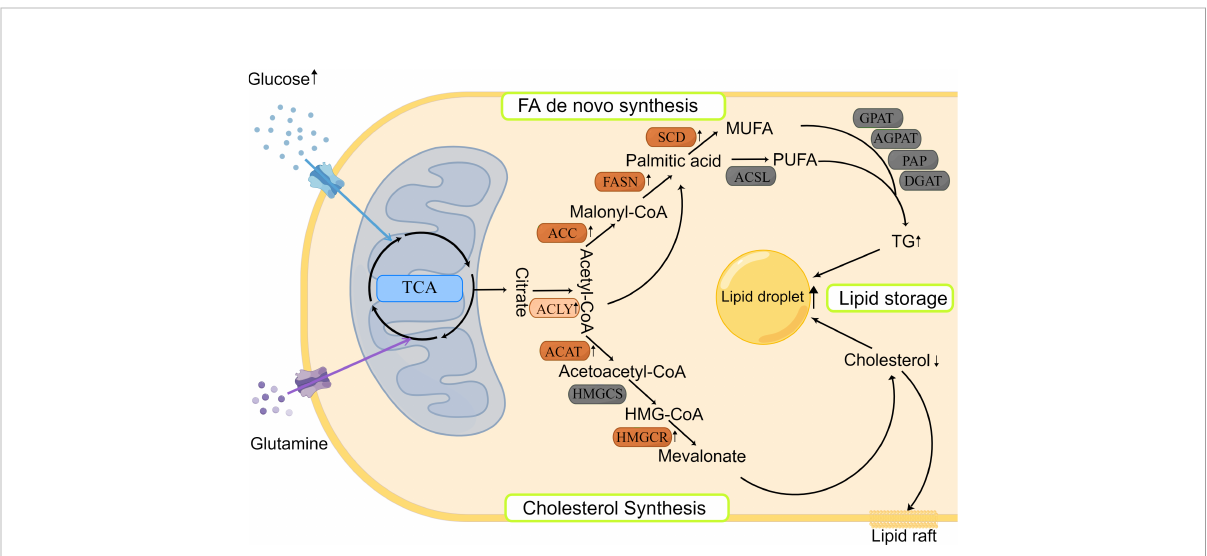
FIGURE 1 Lipid synthesis and storage in HNSCCs. Lipid synthesis begins with citric acid, produced from the TCA cycle, which is used to synthesize different lipids in the cytoplasm. There are two main pathways involved: FA de novo synthesis and cholesterol synthesis. The produced lipids are stored as LDs. Most enzymes involved in lipid synthesis are upregulated in